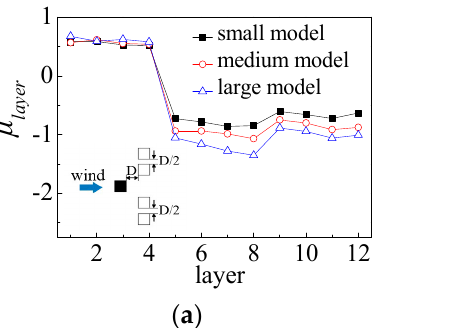
error of layer pressure coefficient. of layer pressure coefficient.